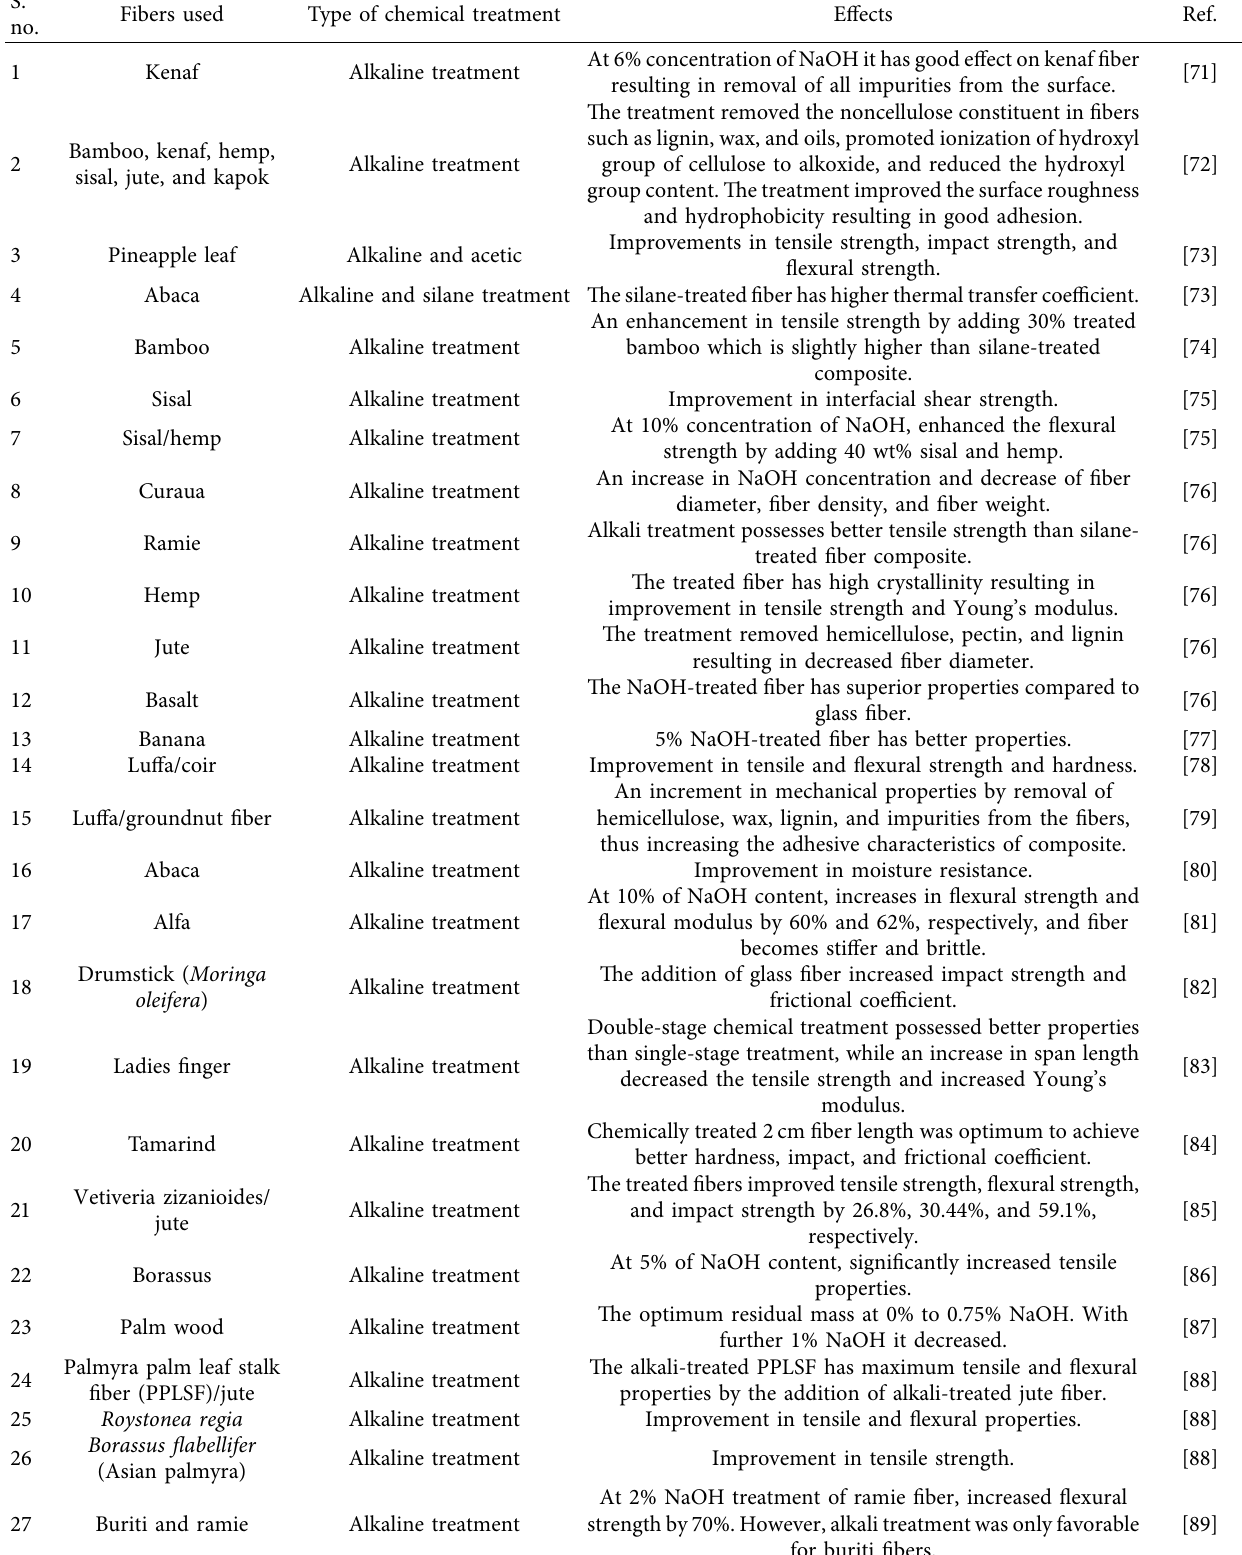
Table 1: Effect of alkaline treatment on various